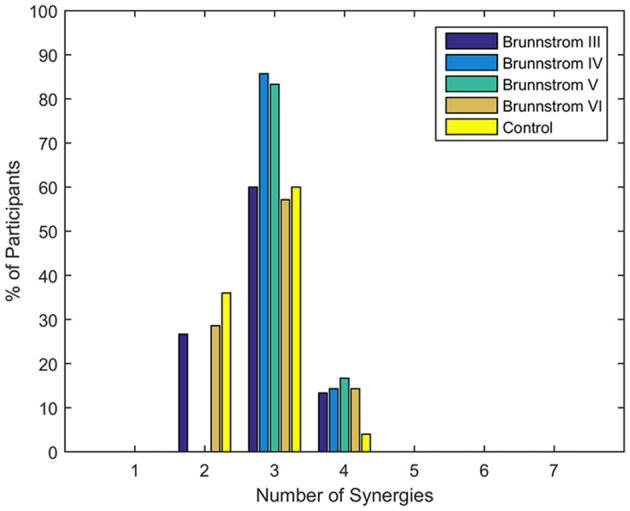
Number of synergies required to reconstruct muscle activation patterns in each Brunnstrom Stage and control group. Typically, 3 synergies were sufficient for all stroke and control groups.